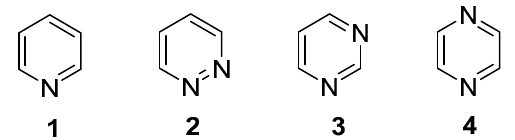
Figure 1. Structures of pyridine ( 1 ), pyridazine ( 2 ), pyrimidine ( 3 ), and pyrazine ( 4 ).